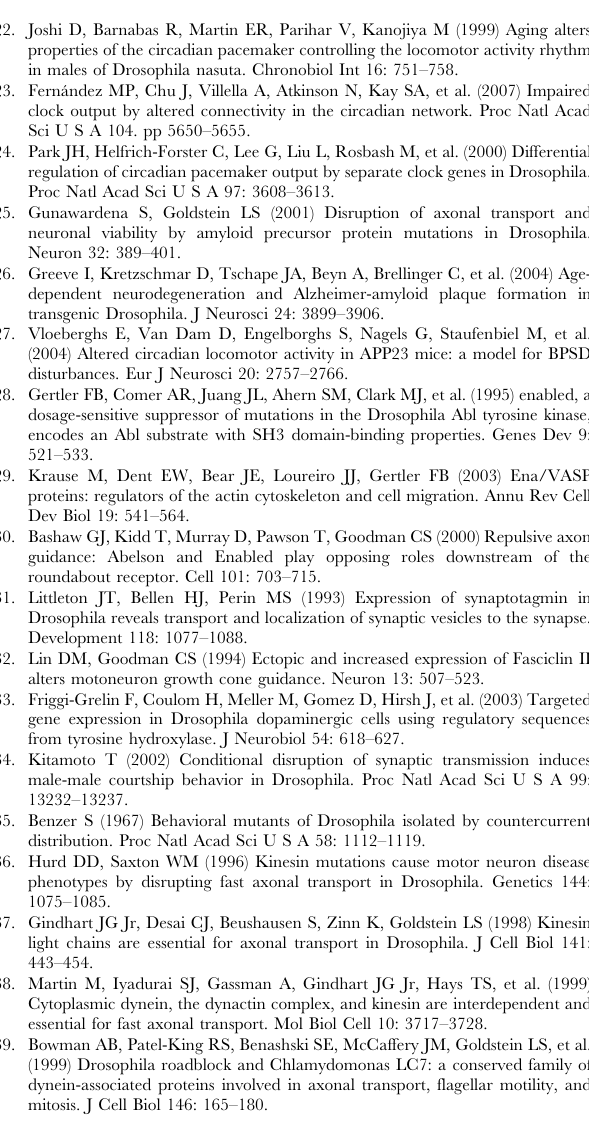
Table S1 Flies were entrained to 12:12h LD cycles for 4 days and then released into DD. Free-running behavior was monitored for 10 additional days. Period values were determined using Clocklab employing Chi-Squared periodogram analysis taking into account only rhythmic individuals. The age and number (n) of flies are indicated for each genotype. Percentage of Rhythmic, Weakly Rhythmic and Arrhythmic is also shown. The mean period, the mean power FFT (power FFT is a quantification of the strength of the circadian rhythm) and total activity levels for those flies is shown.